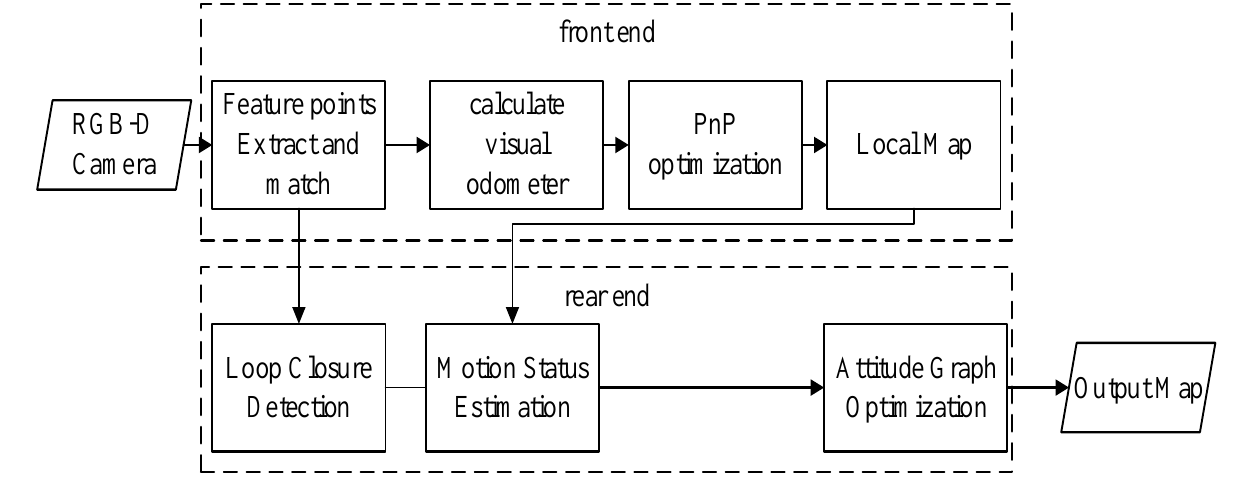
Figure 15. Flow chart of the RTAB-based SLAM.